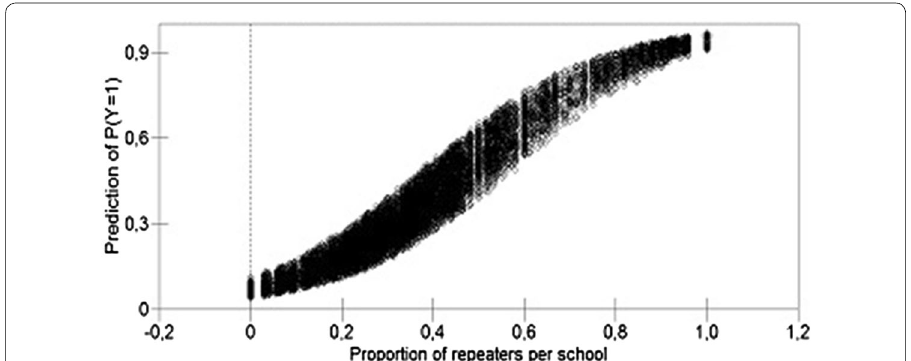
Fig. 3 Predictive probability of repetition given the school proportion of repeaters. Source : authors’ computa‑